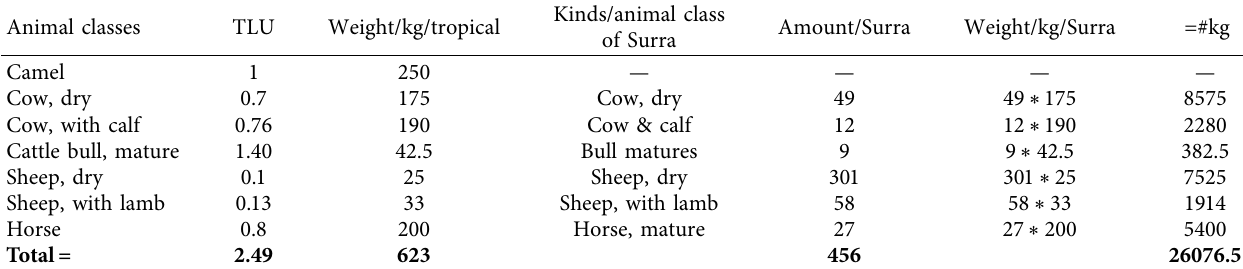
Table 2: Weight of livestock stocking at the Surra government